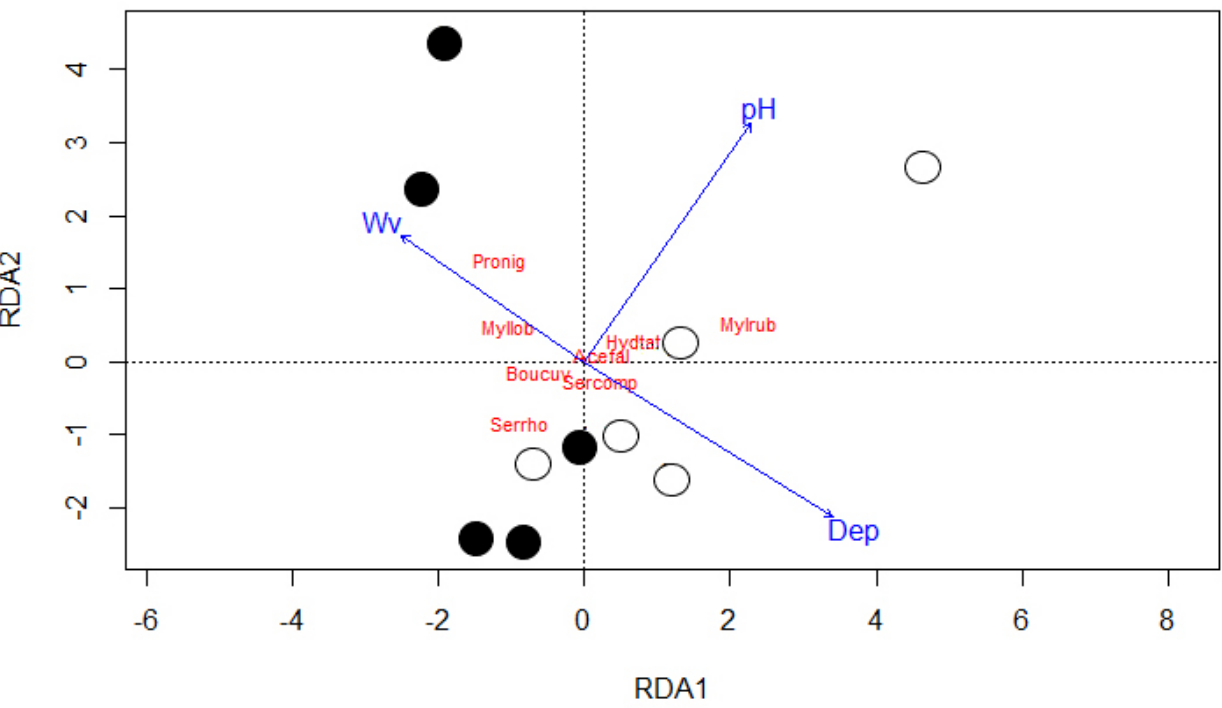
FIGURE 4 | Ordination of the Partial Redundancy Analysis (pRDA) on fish species composition (see codes on Tab. 2) with sites in high water (black circle) low water (white circle) season and abiotic variables relationships (arrows). Dep = Depth; Wv = Water velocity; pH = Hydrogen